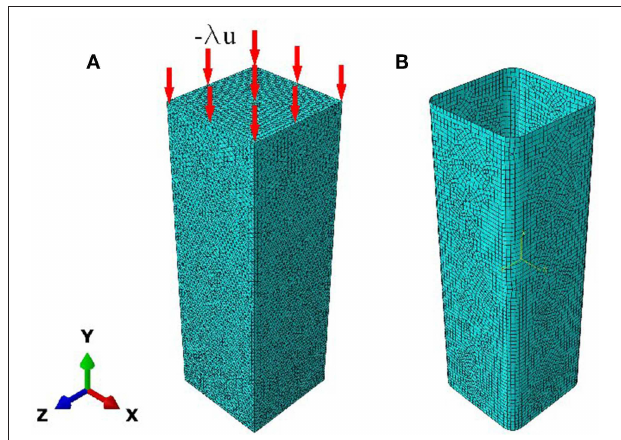
FIGURE 1 | Geometrical representation of the FE model: (A) masonry substrate for unconfined column and (B) external